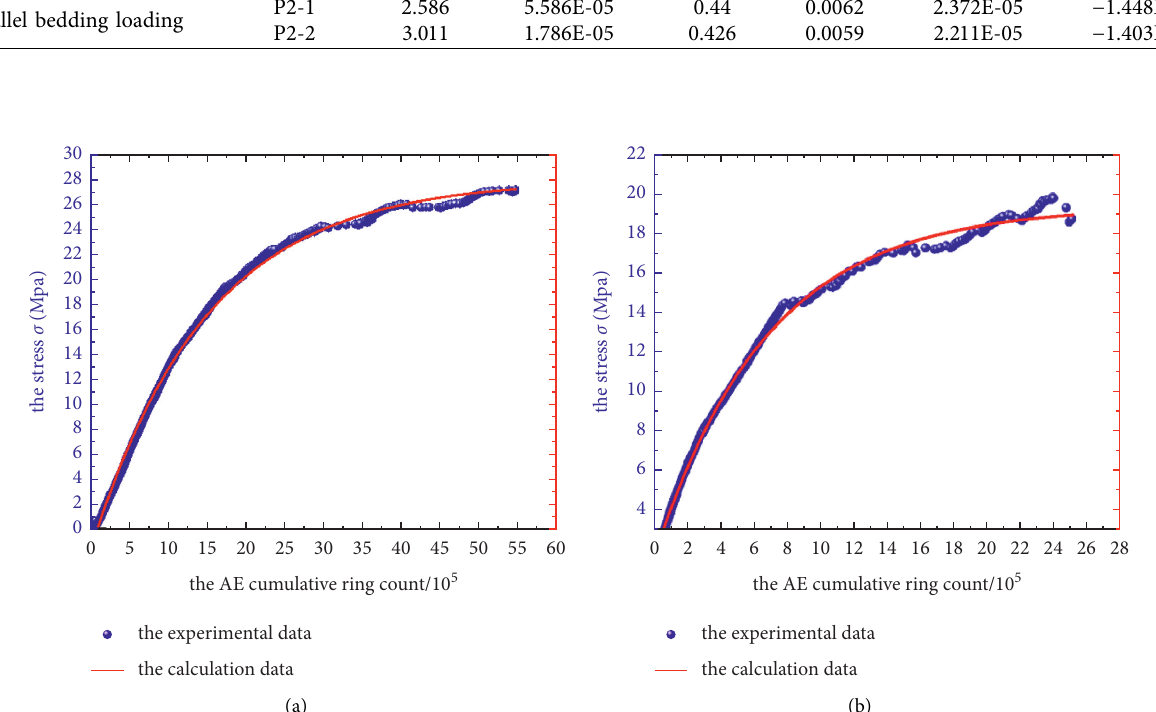
Figure 8: Comparison of test results and model results of cumulative ringing count N and stress σ . (a) V1-1 and (b)